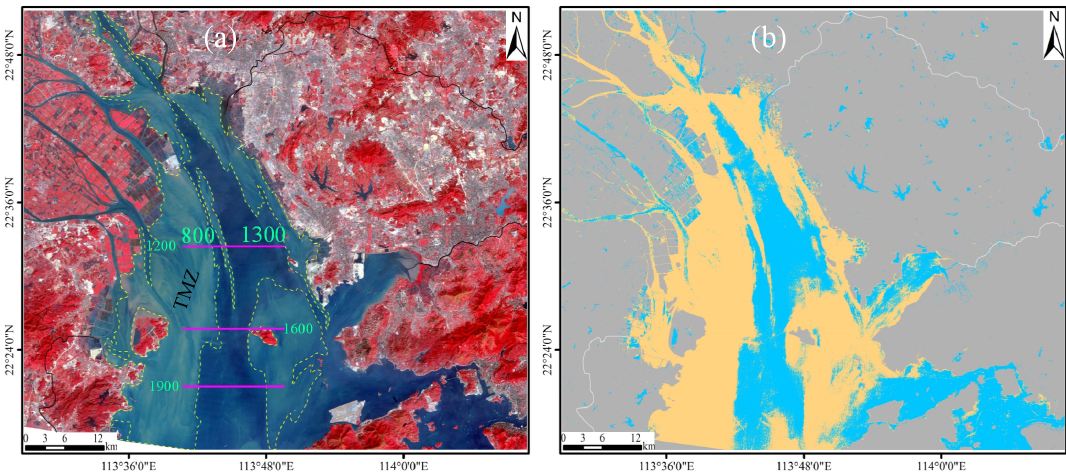
Figure 7. False color imagery (USGS, 1982; NASA, 2001) and the visual-interpretation TMZ results (regions indicated by yellow dashed frames) (Wang et al., 2020b, 2021) (a) and the extracted TMZ results, indicated by mango coloring, (b) in the PRE on 20 November 2004 (low-flow